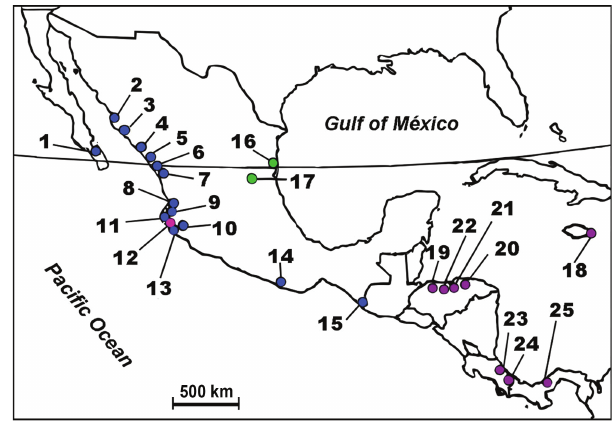
Fig. 1. Map showing specimen localities for Agonostomus monticola . Pacific- A: blue circles (1= La Paz, 2= El Fuerte, 3=Sinaloa, 4= San Lorenzo, 5= Piaxtla, 6= Presidio, 7= Baluarte, 8= Ameca, 9 = Los Arcos, 10= Pitillal, 11= María García, 13=Purificación, 14= Verde, and 15= Suchiate), Pacific-B: pink circle (12= Ayuquila), NE México: green circles (16 = Matamoros, 17= San Luis Potosí), and Caribbean: purple circles (18= Milk River, 19= Lancetilla, 20 = Danto, 21= Cuero and Salado, 22= Bonito, 23= Limón, 24= Boca del Toro, and 25=